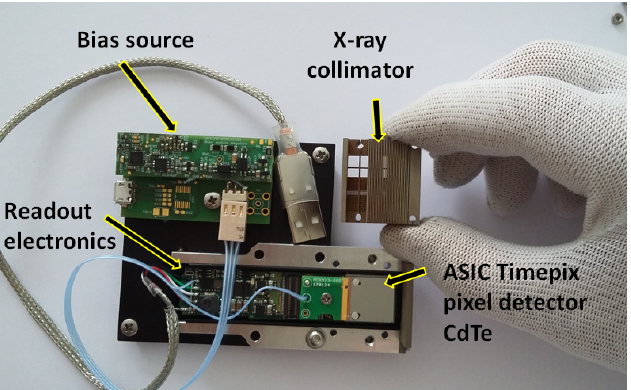
Figure 1. The X-ray and Gamma-ray imaging payload consisting of the pixel detector Timepix, optics-collimator element and bias voltage and readout electronics.